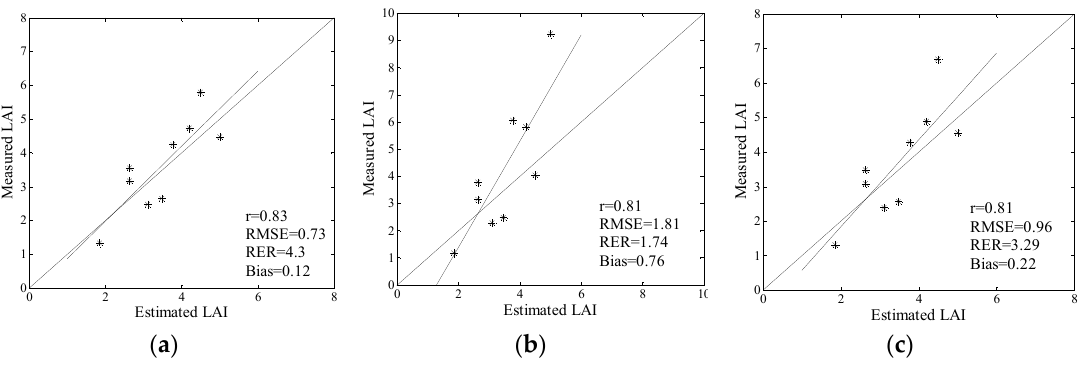
Figure 5. Evaluation of the models constructed from ( a ) the PKB method for the limited dataset; ( b ) the regression method for the limited dataset; and ( c ) the regression method for modeling dataset.